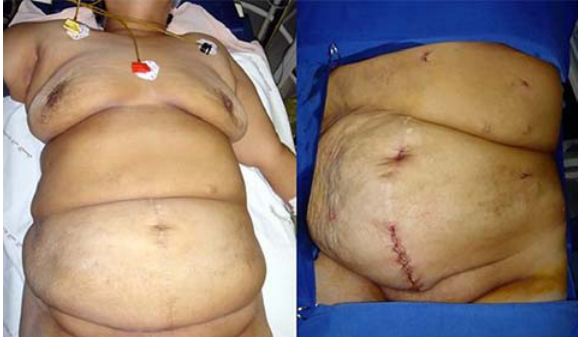
Figure 2 – Patient on the surgical table and final aspect of the surgery. The infra-umbilical incision was used to remove the kid- ney because she already had this surgical scar due to a previous hysterectomy.